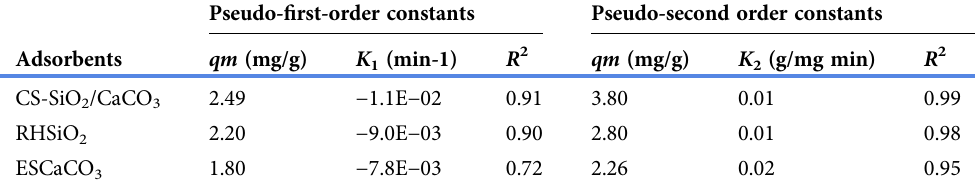
Table 1 Pseudo- fi rst-order and Pseudo-second order constants for adsorption of phenol. Pseudo- fi rst-order constants Pseudo-second order